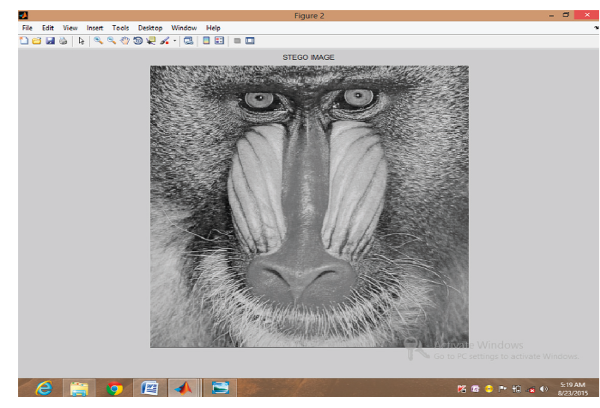
Figure 12: Stego image of baboon.